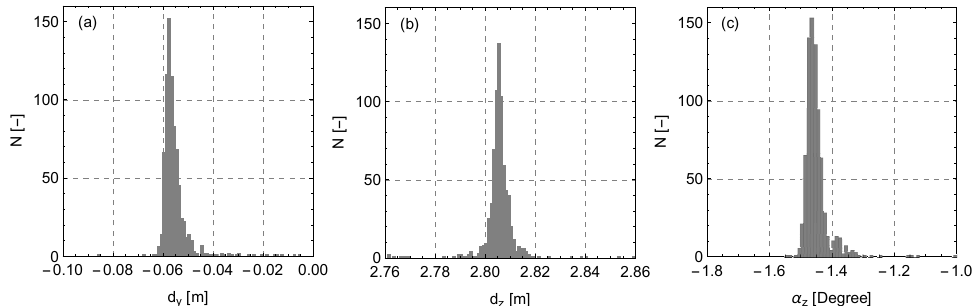
Figure 8. Histograms of the estimated values of the ( a ) transverse 𝑑 𝑦 and ( b ) vertical 𝑑 𝑧 displacement, as well as of ( c ) the yaw alignment 𝑎 𝑧 of the SpinnerLidar in relation to the centre of the rotor.